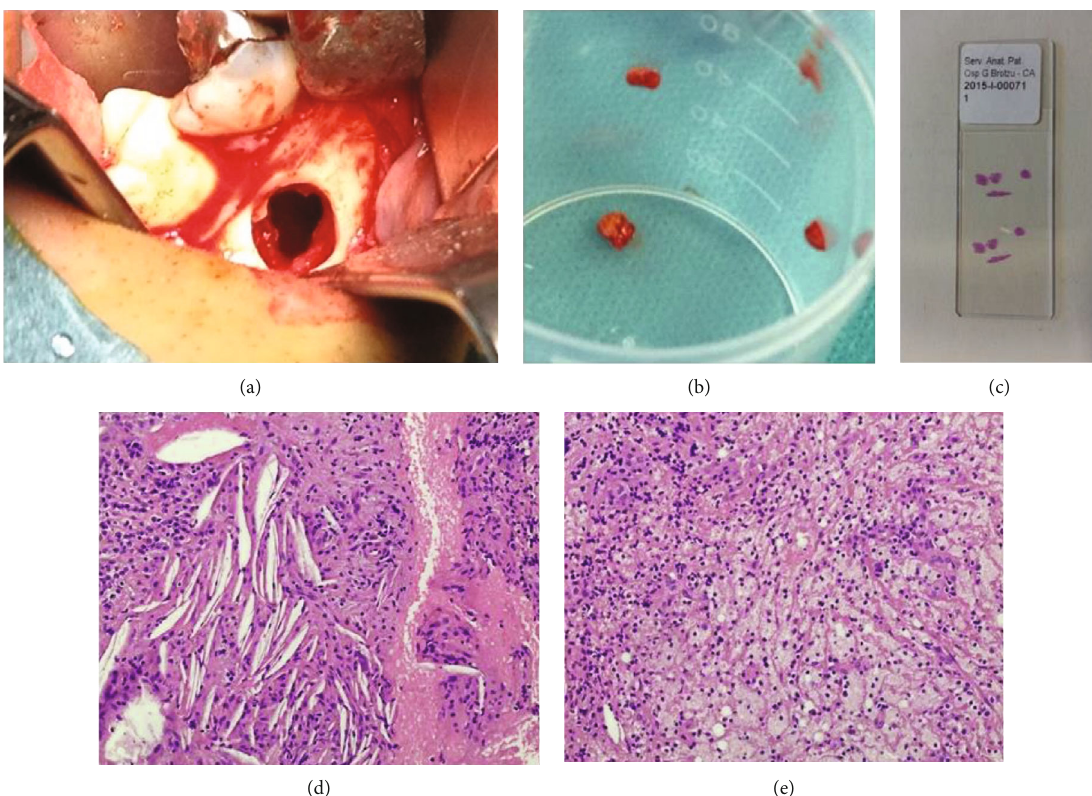
Figure 3: (a) Intraoperative view showing the bone cavity fi lled with serum sanguineous fl uid. (b) Gross specimens of small dimensions collected for histopathological examination. (c) Hematoxylin-eosin histology slide containing the tissue fragments. (d) Photomicrograph shows the lesion to be composed of fi brosclerotic tissue with calci fi cations and cholesterol clefts and the absence of epithelium. (e) Histopathological section revealing the presence of a chronic in fl ammatory in fi ltrate with numerous foamy histiocytes and multinucleated giant